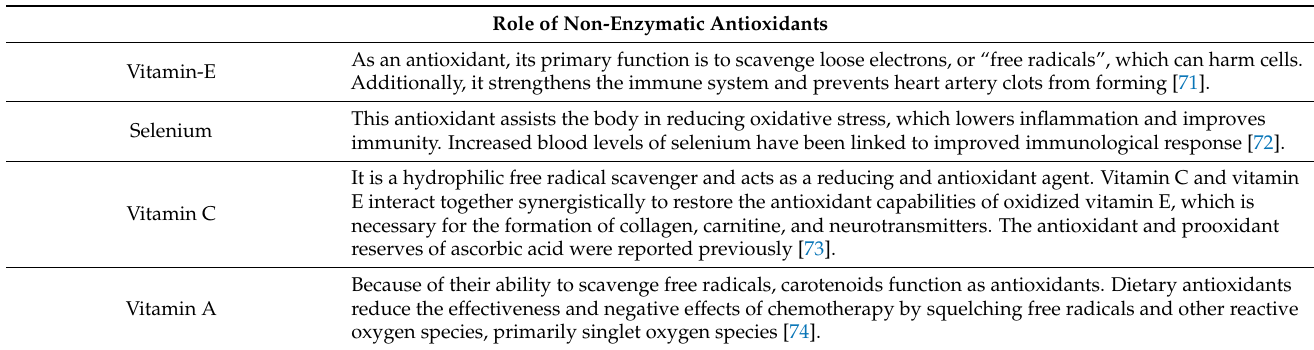
Table 1. Cont. Role of Non-Enzymatic